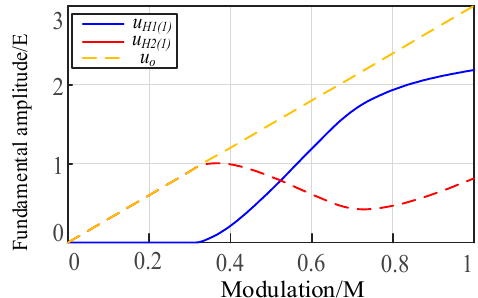
Figure 9. The relationship between the amplitude of the fundamental wave and the modulation index M.